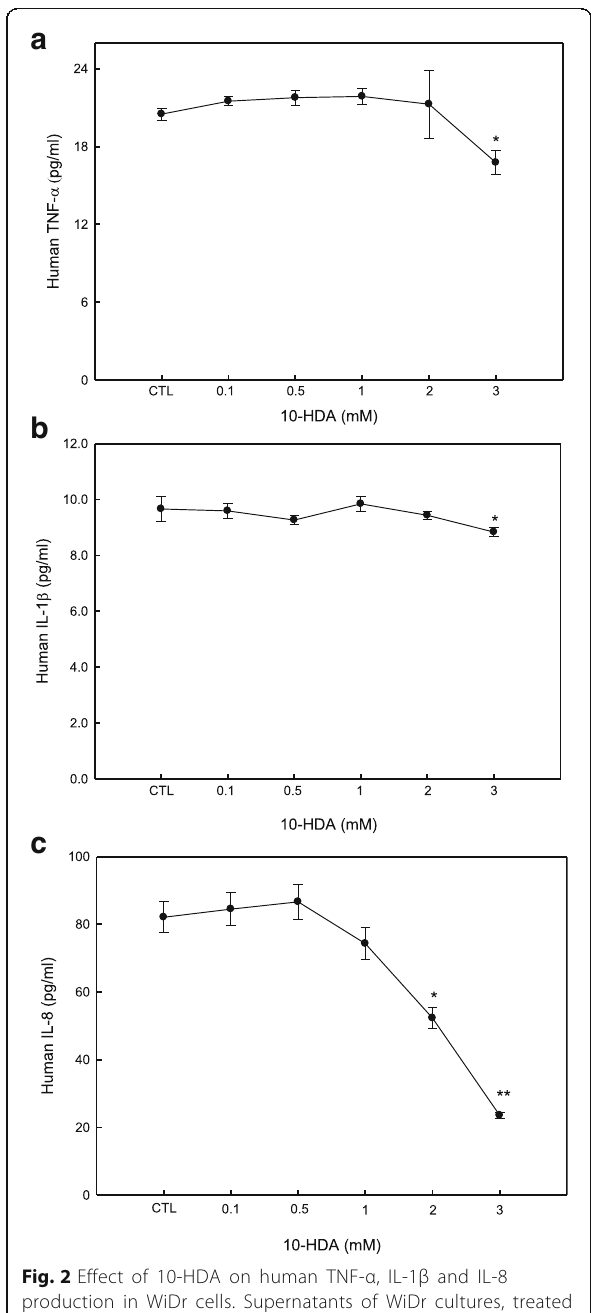
Fig. 2 Effect of 10-HDA on human TNF- α , IL-1 β and IL-8 production in WiDr cells. Supernatants of WiDr cultures, treated with or without 10-HDA (0.1, 0.5, 1, 2 and 3 mM), were collected after 24 h and tested by ELISA for detecting TNF- α ( a ), IL-1 β ( b ) and IL-8 ( c ). CTL represents the control group (without 10-HDA). Each point is a mean ± SD of the triplicates from one representative experiment. * = p ≤ 0.05; ** = p ≤ 0.01 compared to